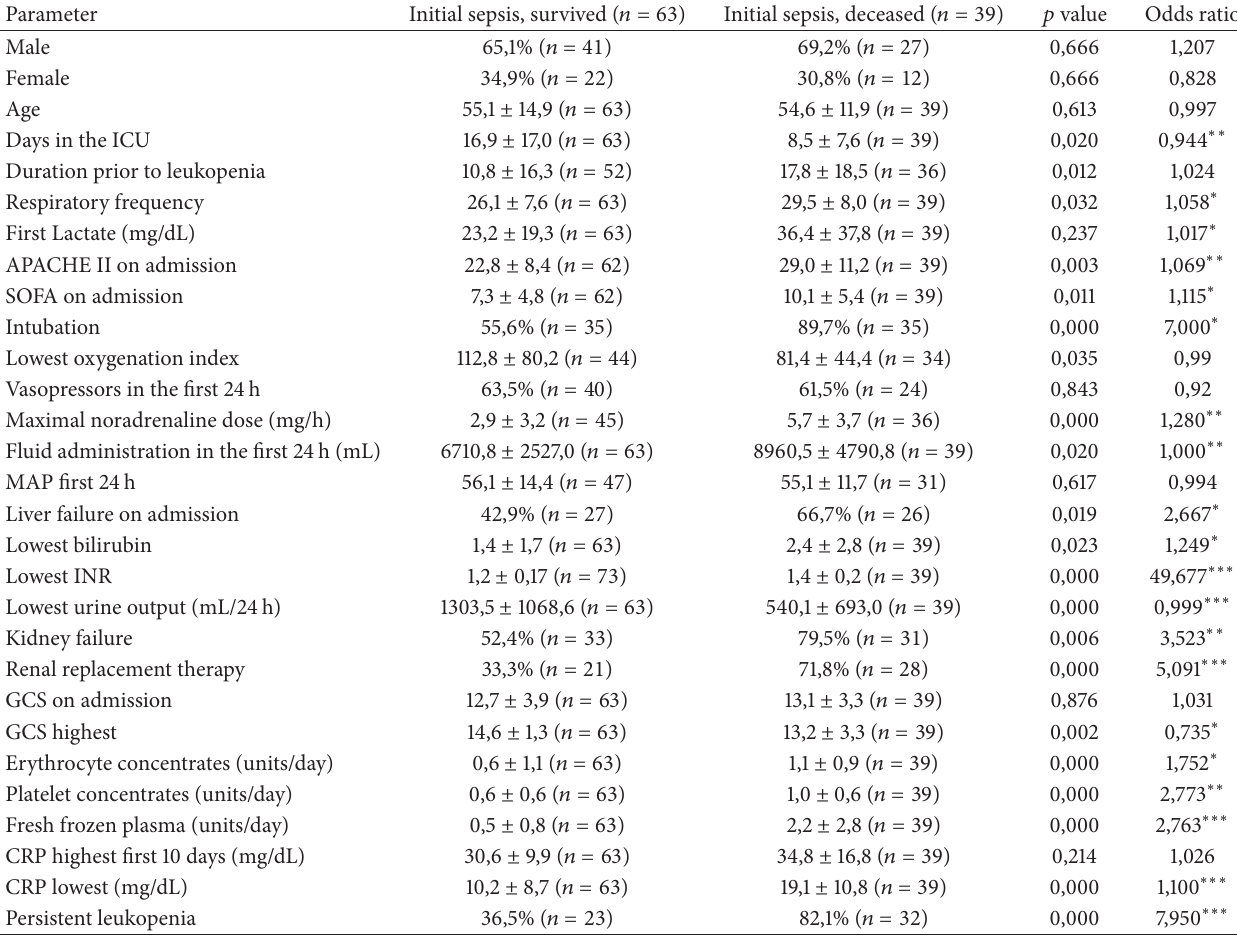
Figure 3: Overview of the number of analyzed patients. Of the 102 patients admitted to the ICU, 39 patients deceased in the initial sepsis phase, while 63 patients overcame it. Of these 63 patients, 17 deceased in the ICU in the recovery phase, while 46 patients survived and were discharged from the ICU. Table 1: Characteristics of patients who manage to overcome the initial sepsis compared to those who decease in the initial septic episode. Values are displayed as mean ± standard deviation; ∗ / ∗∗ / ∗ ∗ ∗ indicate level of